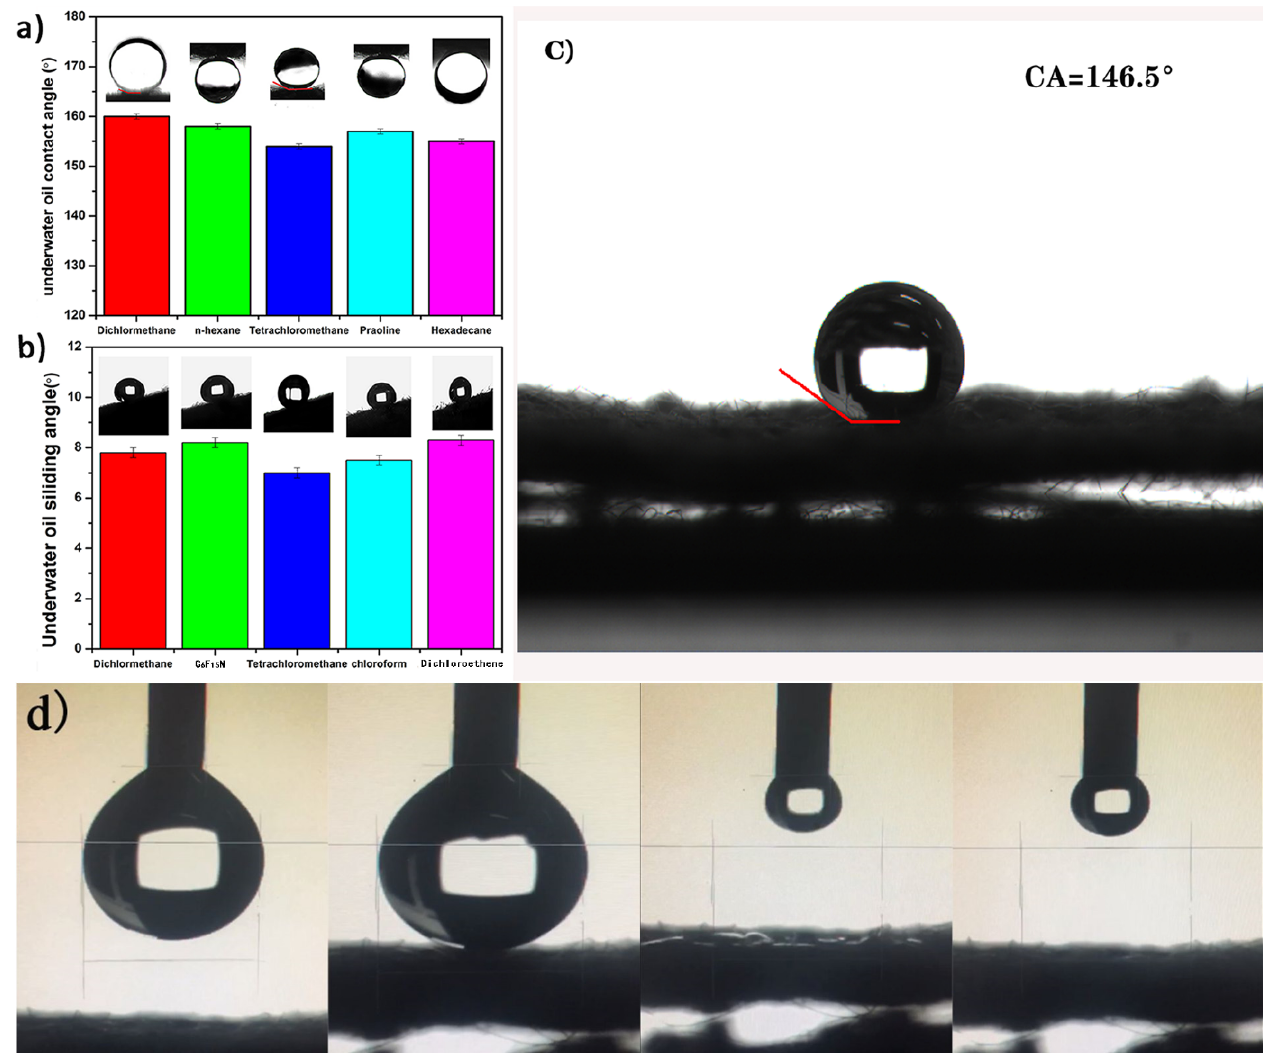
Figure 3. The underwater contact ( a ) angle and sliding angle ( b ) of different oil droplets on the SiO 2 -Na 2 SiO 3 -coated SSF membrane, the hydrophobicity ( c ) of original SSF and the superhydrophilicity ( d ) of SiO 2 -Na 2 SiO 3 -coated.